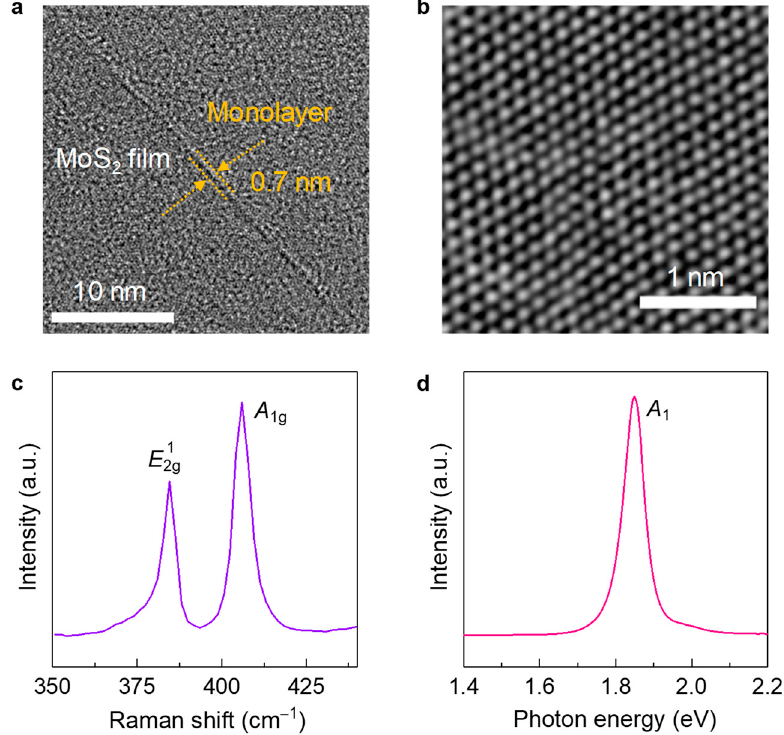
Figure 1. ( a ) TEM and ( b ) high-resolution STEM images of obtained MoS 2 films grown by CVD. Scale bars denote 10 and 1 nm, respectively. ( c ) Raman and ( d ) PL spectra of our MoS 2